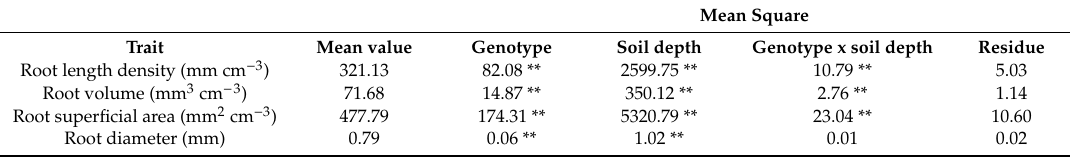
Table 7. Analysis of variance of four root traits (root length density, root volume, root superficial area, and root diameter) for 43 genotypes of C. canephora grown in Nova Ven é cia,